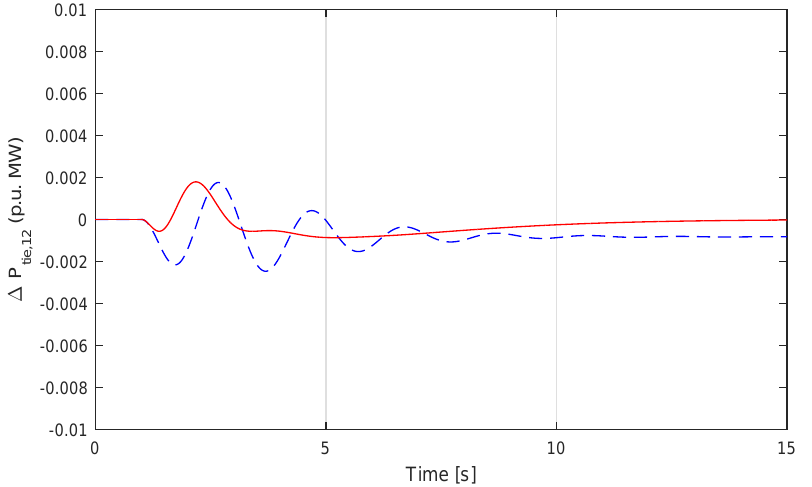
Figure 14. The Compared responding curves ∆ P tie ,12 of V2G system subjected to SOC(solid: proposed, dashed: